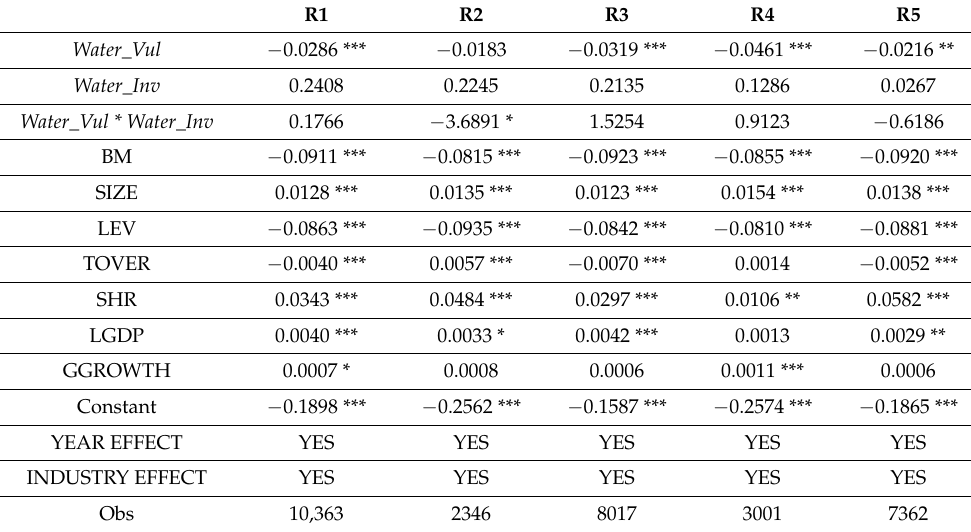
Table 8. The moderating effect of water investment on capital